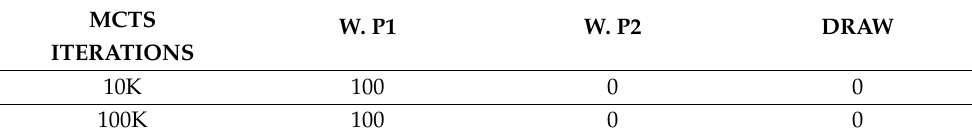
Table 3. Results for unique